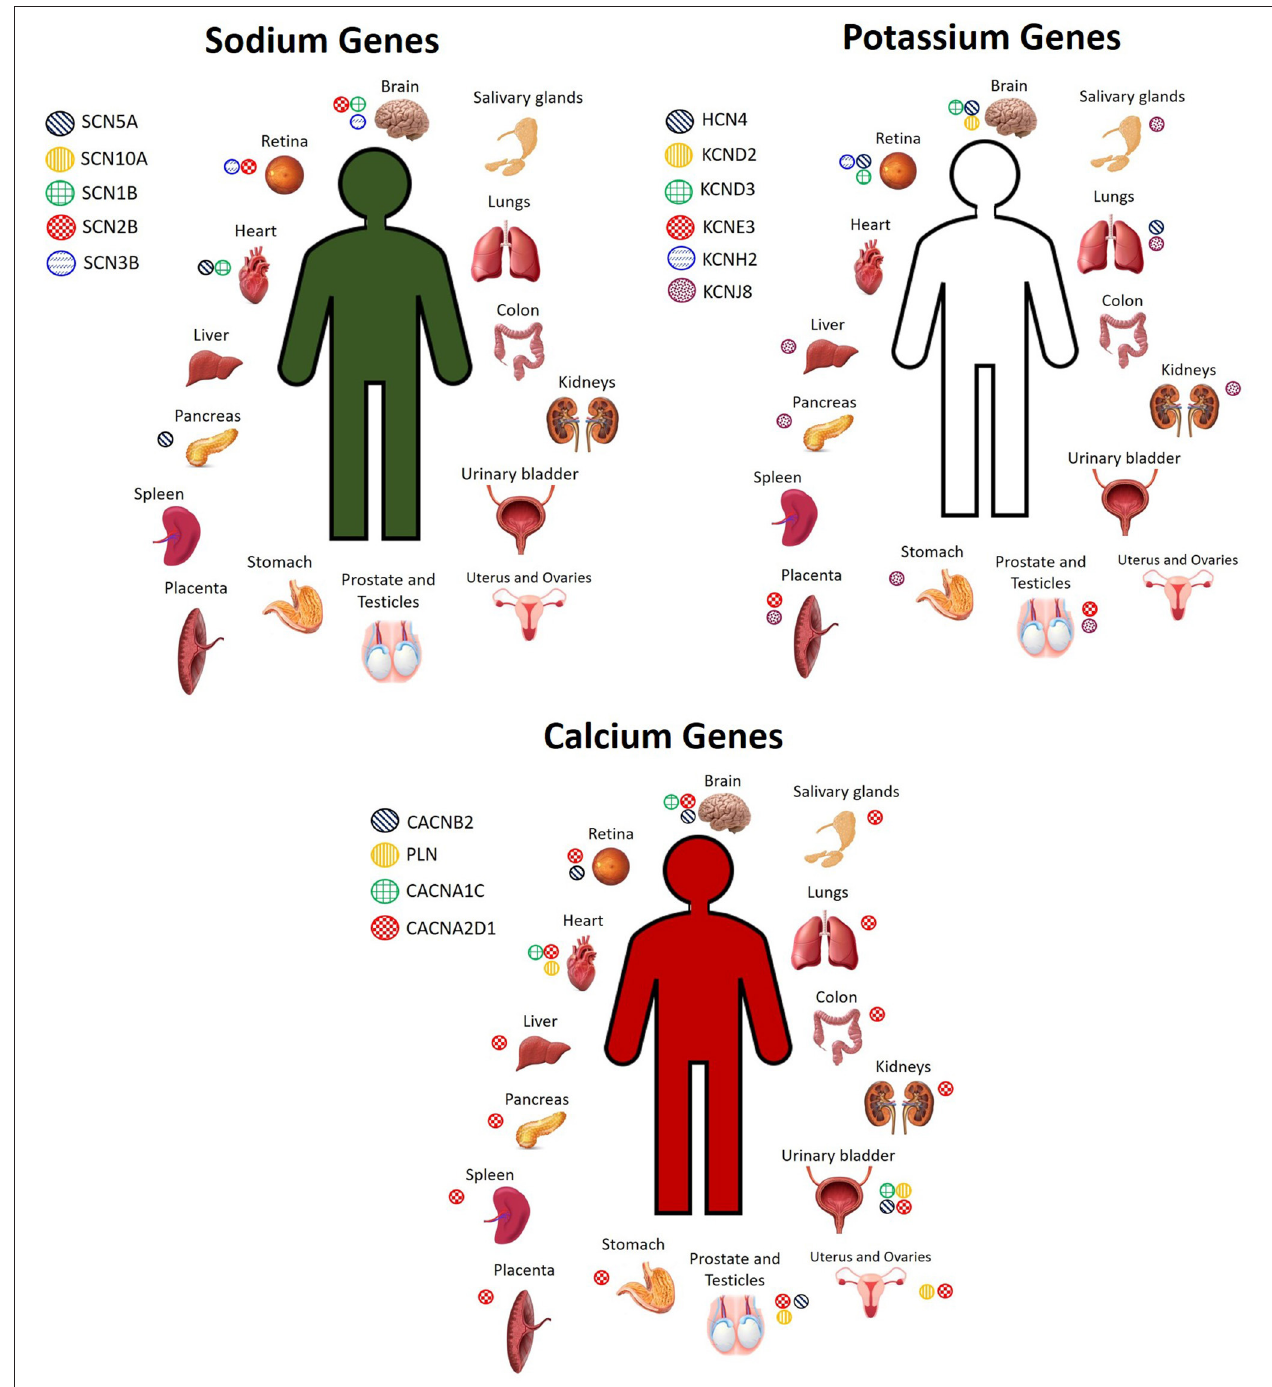
FIGURE 1 | Cell and tissue types in which sodium, potassium, and calcium channel BrS candidate genes encode for high levels of protein expression. Not pictured: Sodium genes: SCN5A : plasma, pancreas juice. SCN10A : monocytes, neutrophil, B cells, T cells, skin. SCN2B : spinal cord, fetal heart, fetal brain. SCN3B : fetal brain. Potassium genes: HCN4 : plasma, PBMCs, fetal heart. KCND2 : fetal brain. KCND3 : fetal brain, bones. KCNJ8 : lymph node, bone marrow, stromal cells, nasopharynx, rectum, thyroid, adrenal, breast, gallbladder, skin, cervix, seminal vesicles Calcium genes: CACNA2D1 : serum, plasma, PBMCs, lymph nodes, tonsil, bones, skin, bone marrow, esophagus, adipocytes, fetal brain, frontal cortex, cerebral cortex, cerebral spinal fluid, spinal cord, fetal heart, oral epithelial, cardia, fetal gut, rectum, thyroid, adrenal, gallbladder, urine, fetal ovary, fetal testis, seminal vesicles. PLN : tonsil, fetal heart, esophagus, urinary bladder, seminal vesicles. CACNB2 : fetal brain. CACNA1C : frontal cortex, fetal heart, urinary bladder. TRPM4: Spinal cord, nasal respiratory epithelium, rectum, breast (29).